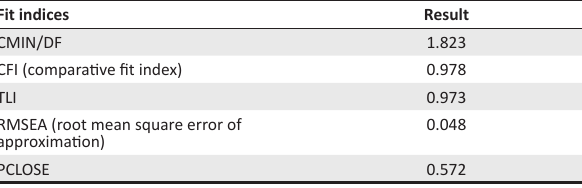
TABLE 5: Model fit summary of the structural equation model.